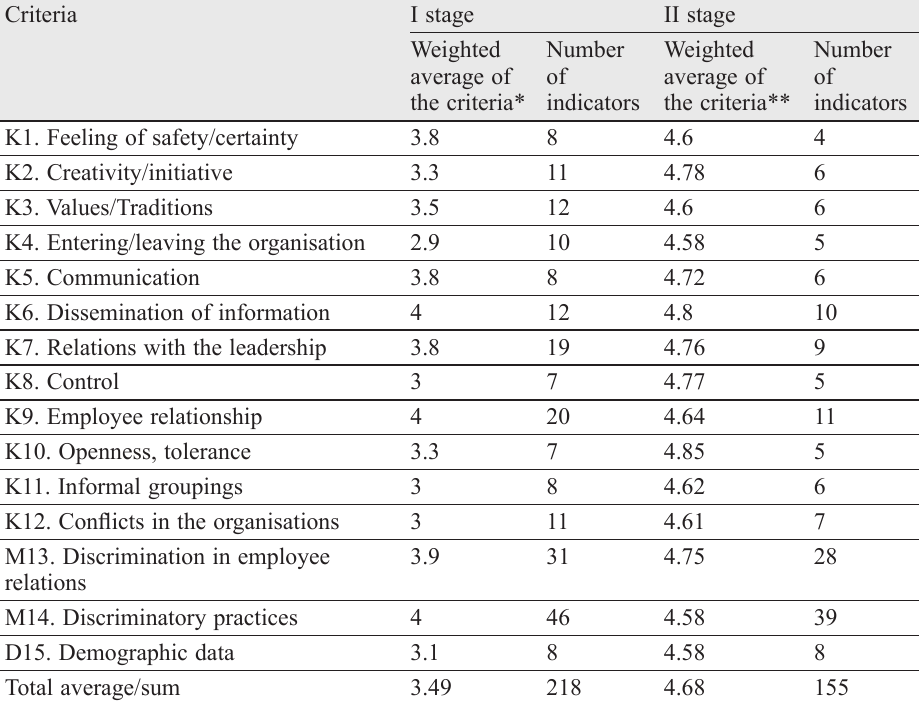
Table 3 . Comparison of the weighted average of the criteria presented for assessment and the number of indicators in both stages Criteria I stage II stage Weighted Number Weighted Number average of of average of the criteria* indicators the criteria**